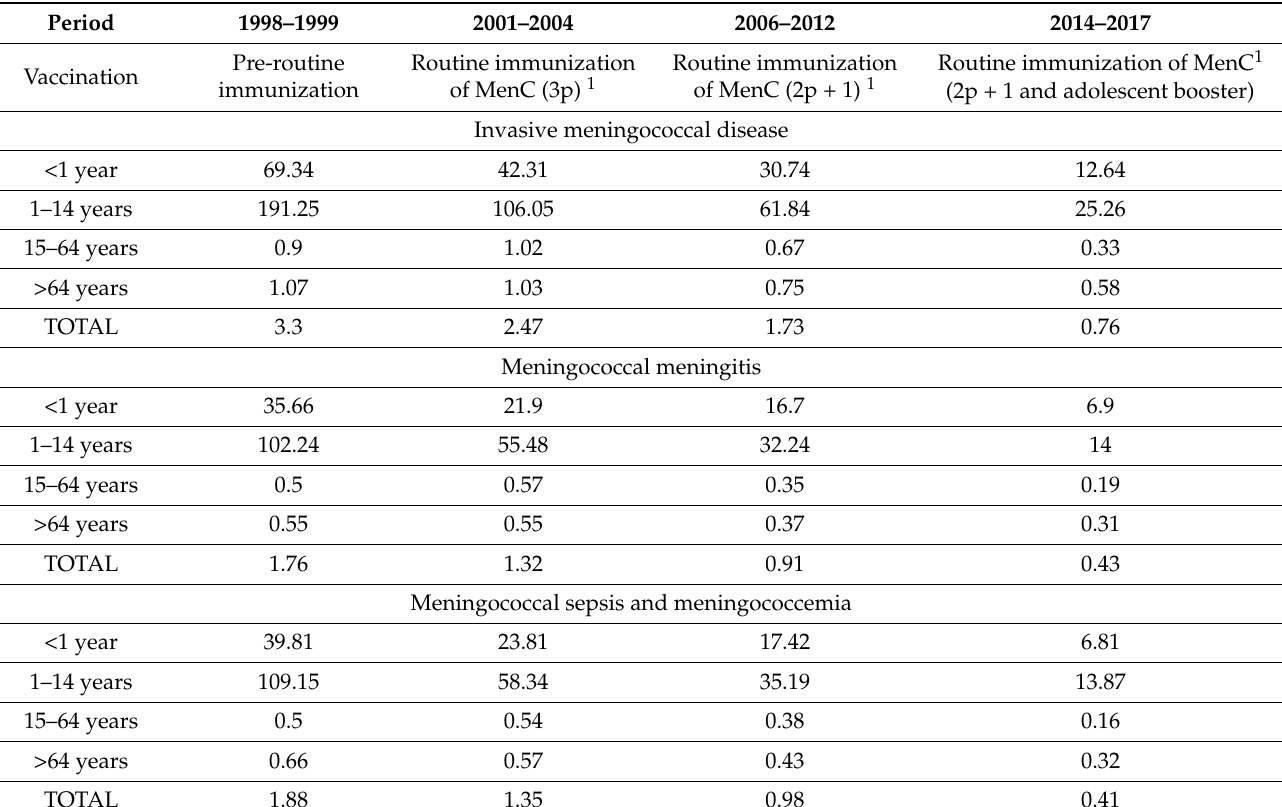
Figure 1. Trends on hospitalization of meningococcal diseases in Spain from 1998 to 2017: ( A ) number of hospitalizations, ( B ) hospitalization rate (expressed in 1/100,000 population). Table 1. Hospitalization rate of meningococcal infections disaggregated into different periods